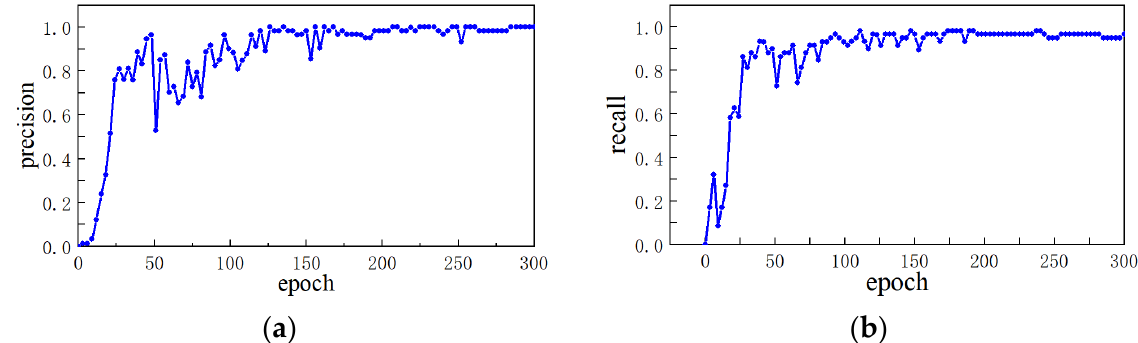
4 of 20 Figure 1. YOLOv5s network structure diagram. The precision rate is relative to the prediction results, which indicates how many samples are among the positive samples predicted. The recall rate is relative to the initial samples, which indicates how many positive samples are correctly predicted in the sam- ples.